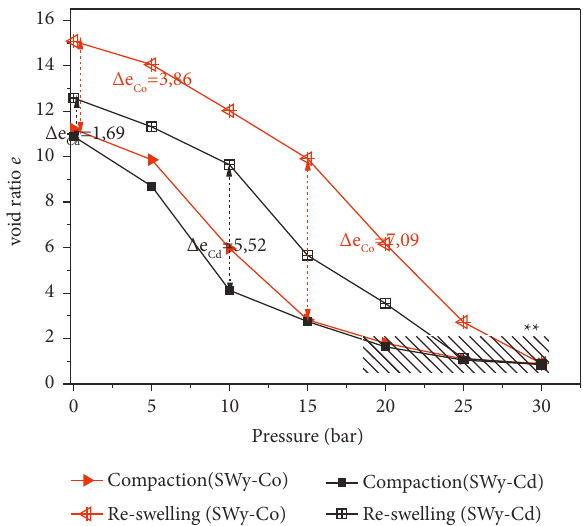
Figure 3: Equilibrium void ratio e for the compaction and reswelling versus applied pressure for SWy-Co and SWy-Cd samples. ∗ ∗ Zone of maximum applied pressure